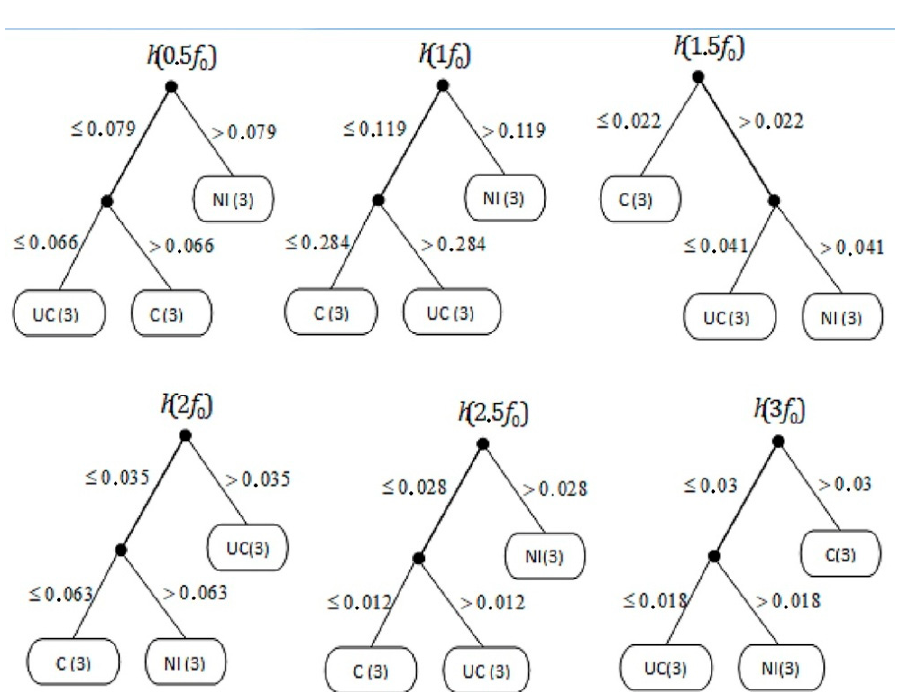
Figure 11. Inductive decision trees for t1 , where C—efficient engine, NI—injection inefficient, and UC—pressure inefficient.